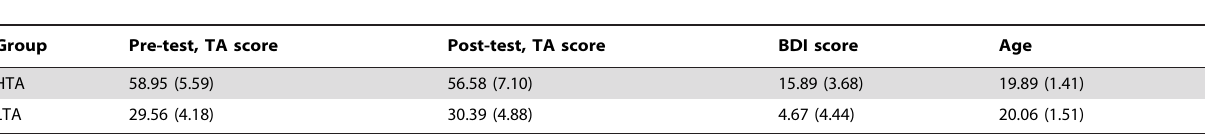
Table 1. Demographic information for the high-trait-anxious (HTA) and low-trait-anxious (LTA) groups (Mean 6 Standard